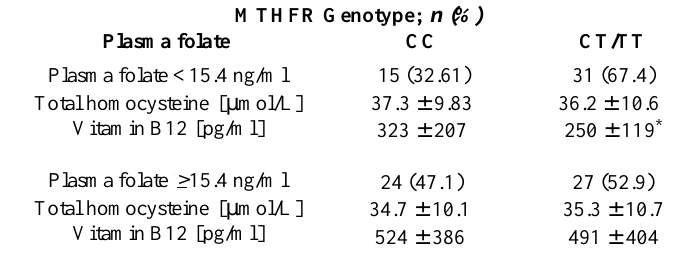
Table 2. Plasma total homocysteine and vitamin B12 concentrations in the group of patients with CVD accord- ing to methylenetetrahydrofolate reductase (MTHFR) C677T genotype and plasma folate status. * Vitamin B concentrations in subjects with folate levels < 15.4 ng/ml and > 15.4 ng/ml. Different from CC (p < 0.001) and CT/TT (p < 0.01), P-value based on t test for differences between